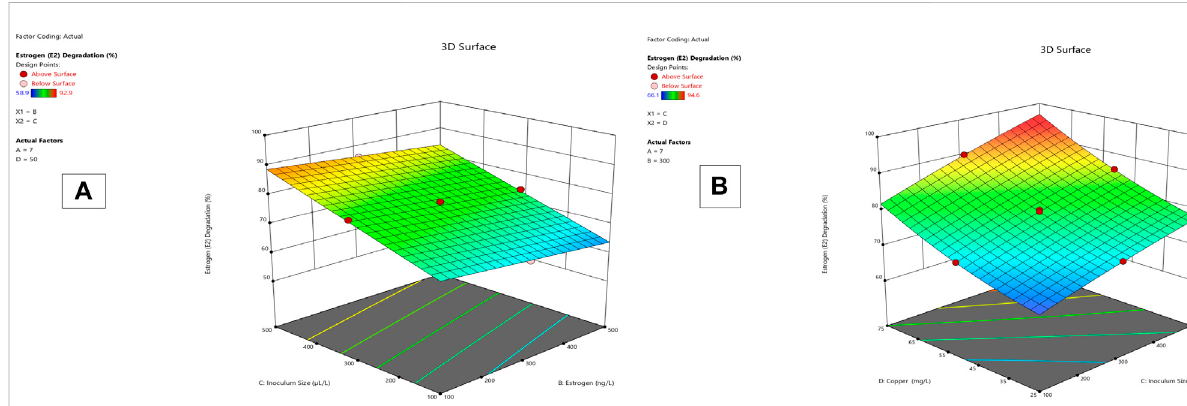
FIGURE 3 E2 degradation 3D mesh diagram for Lysinibacillus. BP1 (A) and Lysinibacillus. BP2 (B) .